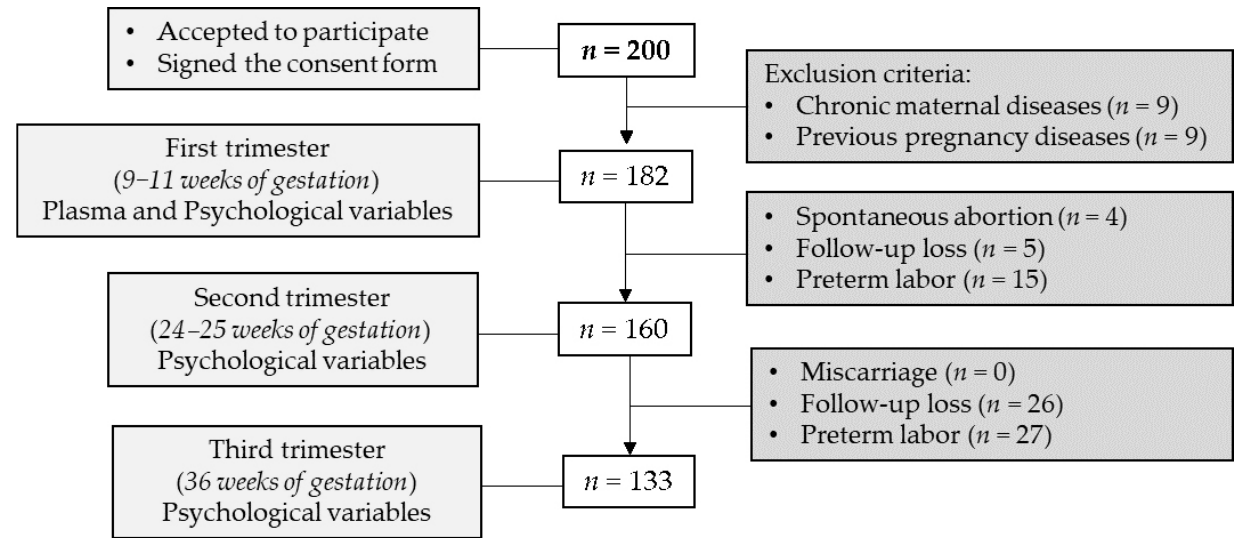
Figure 1. Flow-chart of study participants. Exclusion criteria: chronic maternal disease (i.e., hypertension, obesity, diabetes mellitus, inflammatory or immune deficiency diseases previous pregnancy) and diagnoses of obstetrical complications before. Sample size ( n ) is shown between